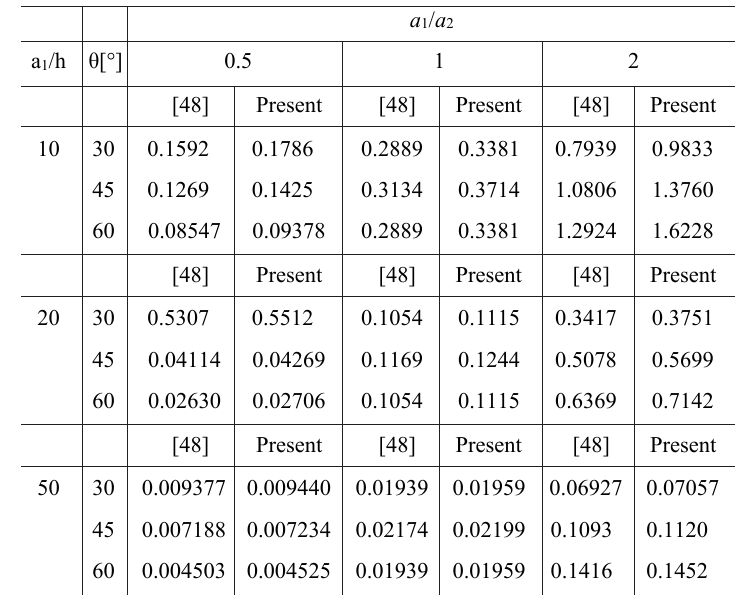
Table 3. Critical buckling loads (in N/mm) for uniaxial compressive loads, laminate L1 simply supported on all edges (SS-2)